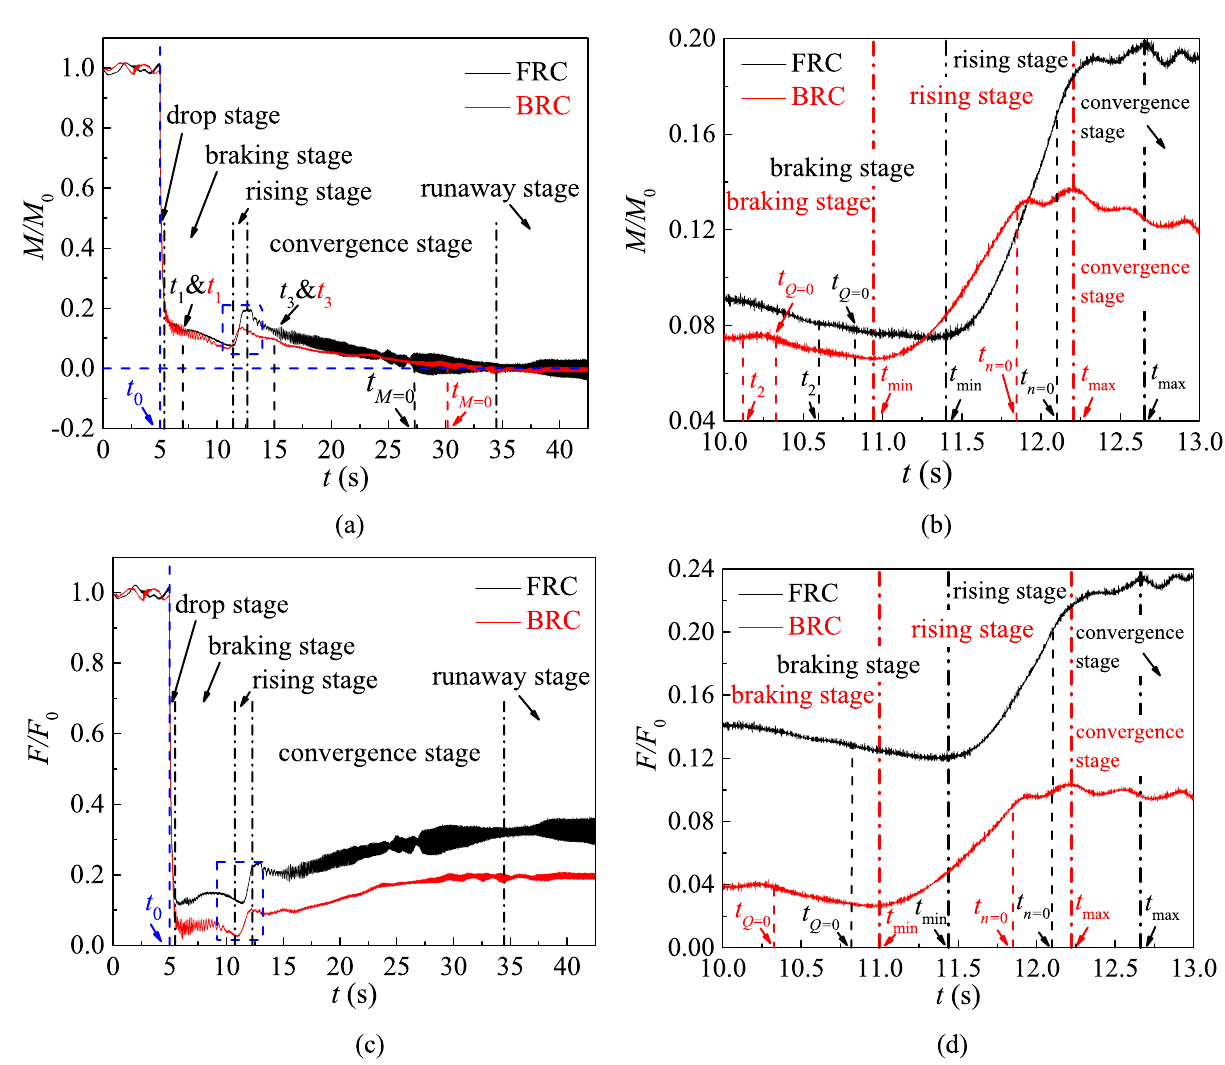
Figure 8. Torque and axial force curve under FRC and BRC, ( a ) torque curves, ( b ) detail torque curves in stage 3, ( c ) axial force, ( d ) detail axial force in stage